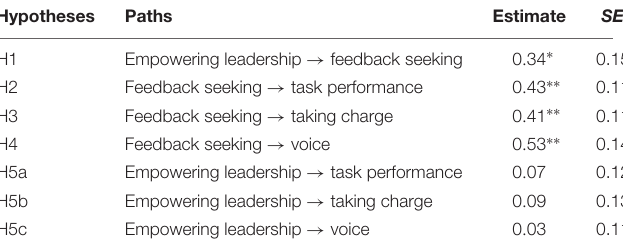
TABLE 3 | Standardized direct path coefficients of the hypothesized